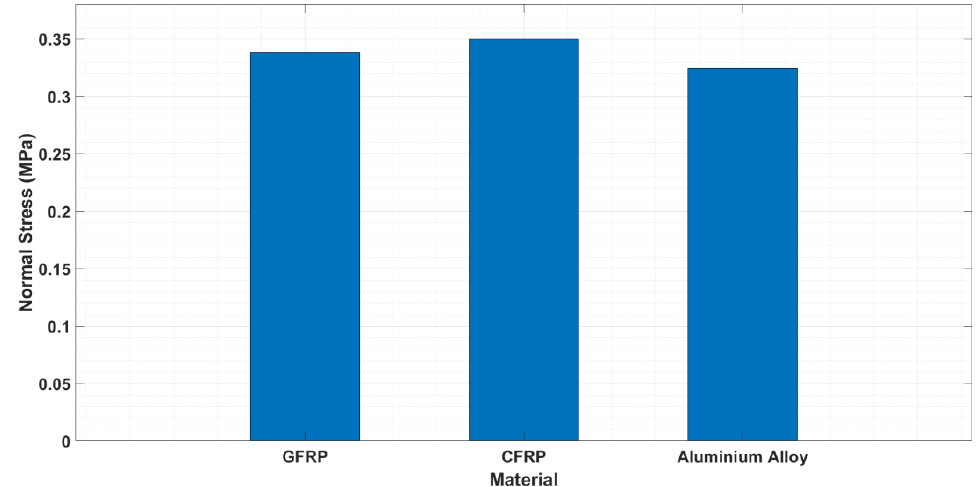
Figure 37. Comparative normal stress variations on the primary aerospace materials.